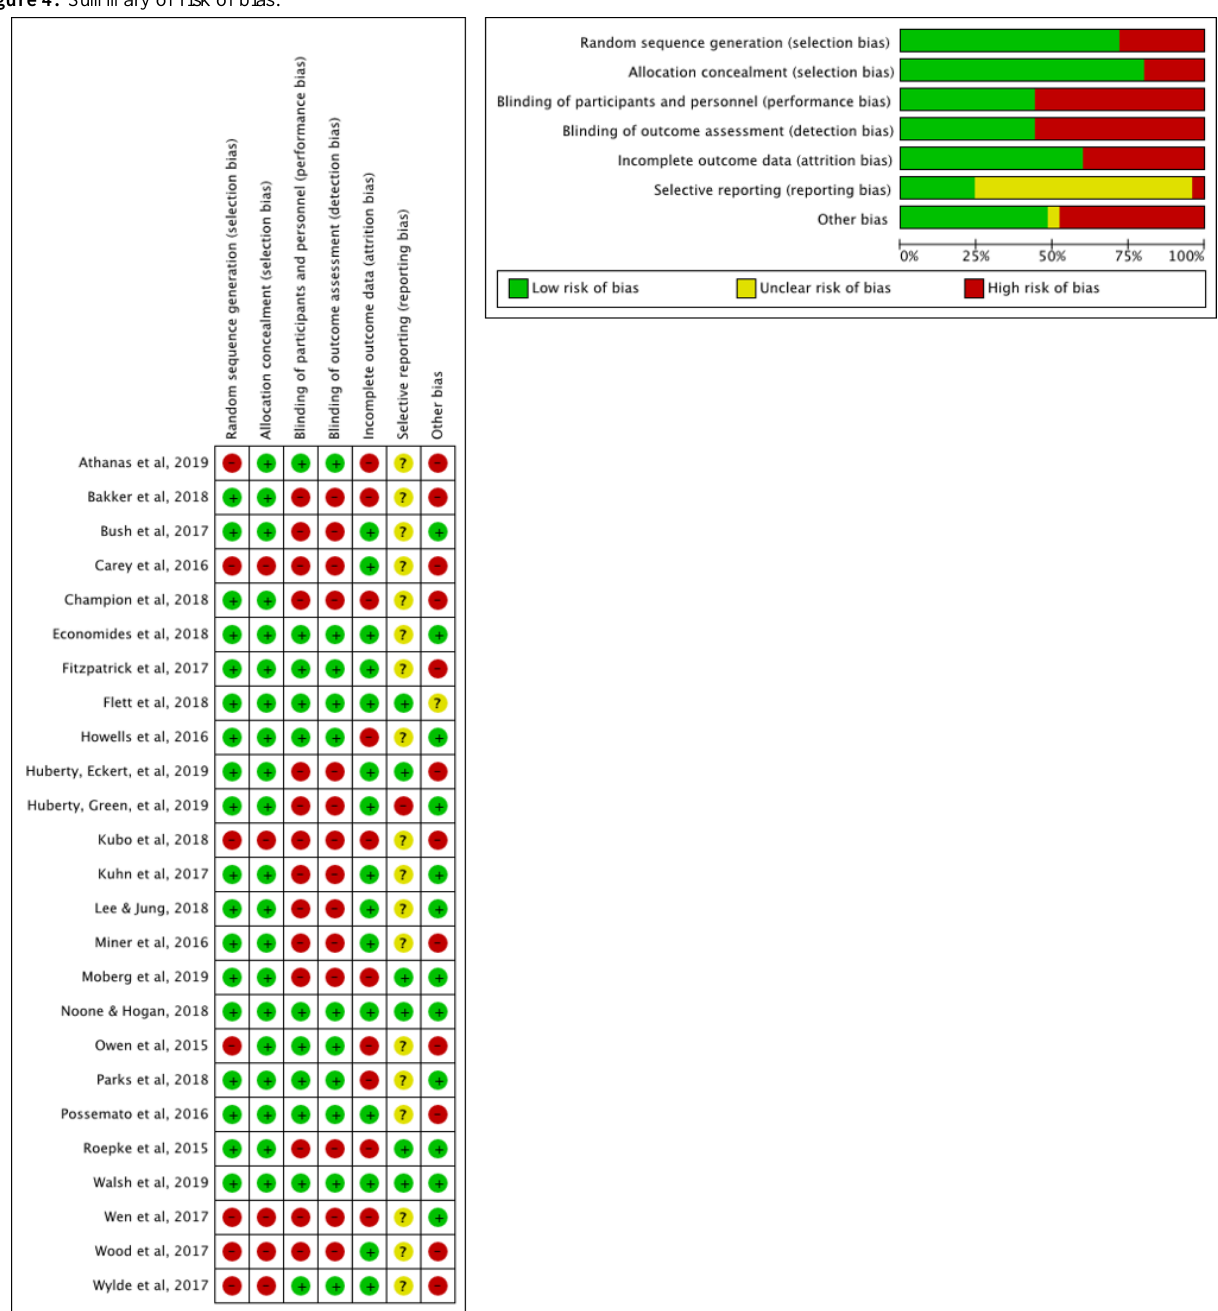
Figure 4. Summary of risk of